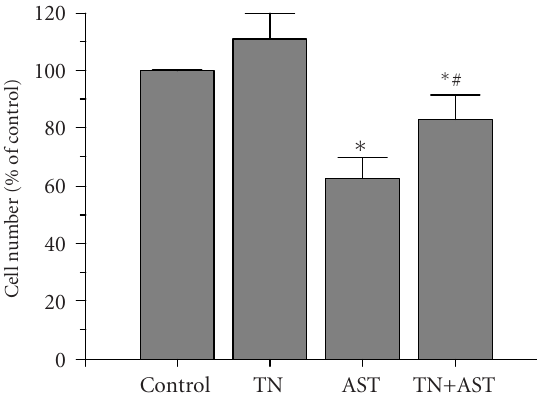
Figure 4. Tetranectin counteracts angiostatin-induced inhibi- tion of proliferation of endothelial cells. HUVECs were seeded overnight in 96-well plates (5000 cells/well). The following day, fresh medium supplemented with basic fibroblast growth factor (bFGF; 10ng/mL) was added. Where indicated, tetranectin (TN; 100 nM) and/or AST K1-4 (200nM) were added to triplicate wells. Cell numbers were counted after 72 hours. AST K1-4 significantly reduced the number of cells obtained ( P < . 008; indicated by ∗ ). There were, however, significantly more cells in cultures treated with the combination of tetranectin and AST K1-4 than in those treated with AST K1-4 alone ( P < . 039; indicated by #). Note that cultures treated with AST and tetranectin still have less cells than control cultures ( P < . 05).